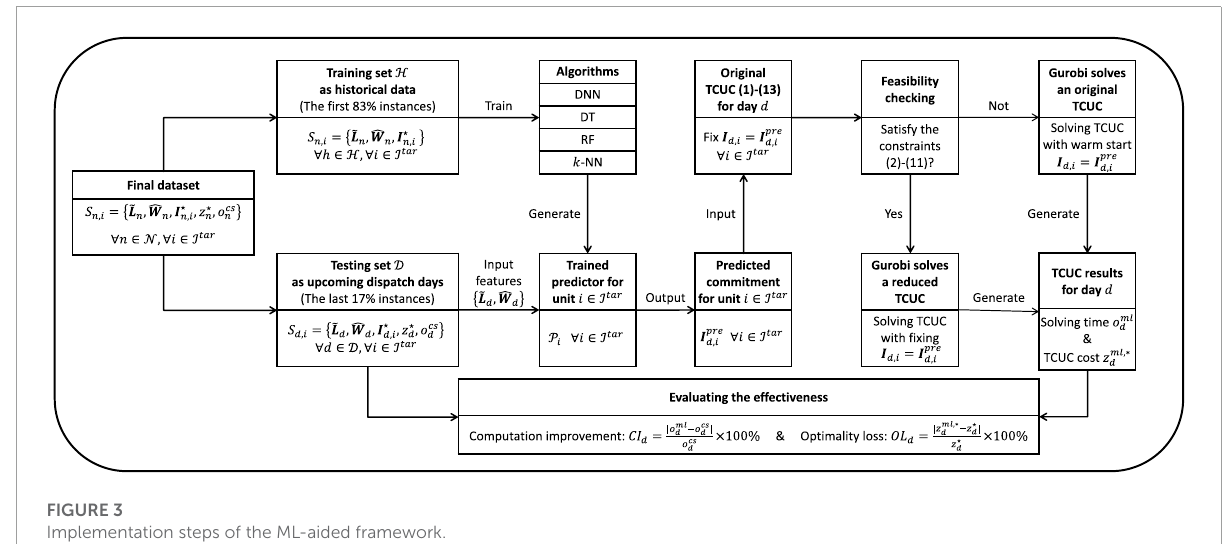
FIGURE 3 Implementation steps of the ML-aided framework.